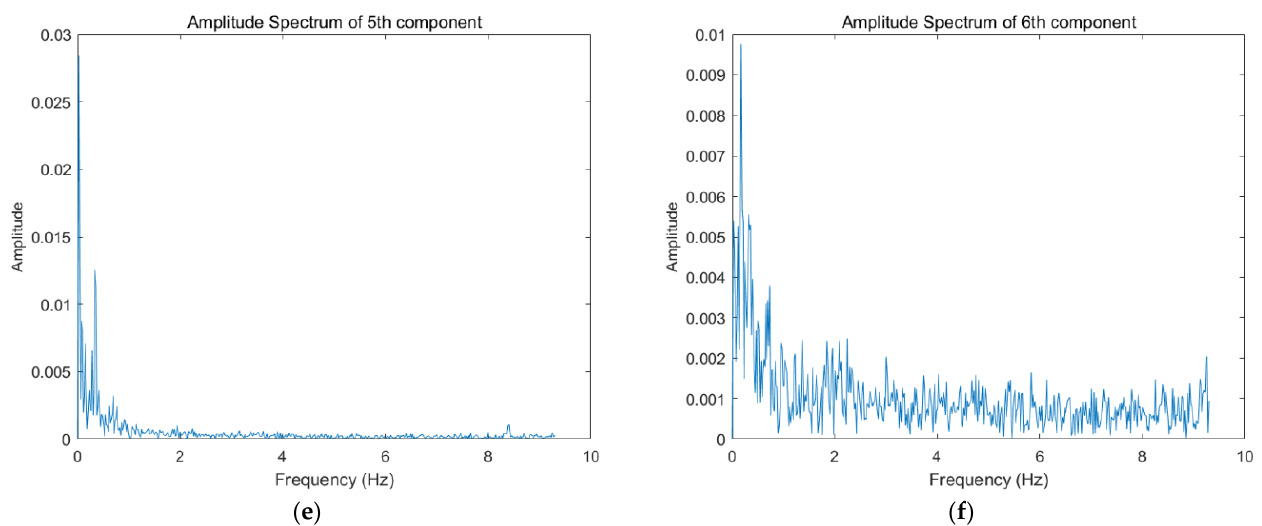
Figure 10. Amplitude spectrum of each order principal component: ( a ) Amplitude spectrum of first component; ( b ) Amplitude spectrum of second component; ( c ) Amplitude spectrum of third component; ( d ) Amplitude spectrum of fourth component; ( e ) Amplitude spectrum of fifth component; ( f ) Amplitude spectrum of sixth component.